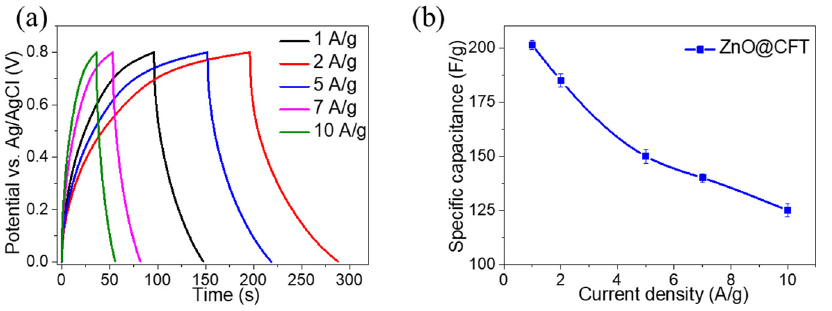
Figure 7. ( a ) Charge/discharge curves of ZnO@CFT electrodes measured against various current densities in the potential range of 0.0–0.8 V. ( b ) Specific capacitance of the ZnO@CFT electrode versus current density.